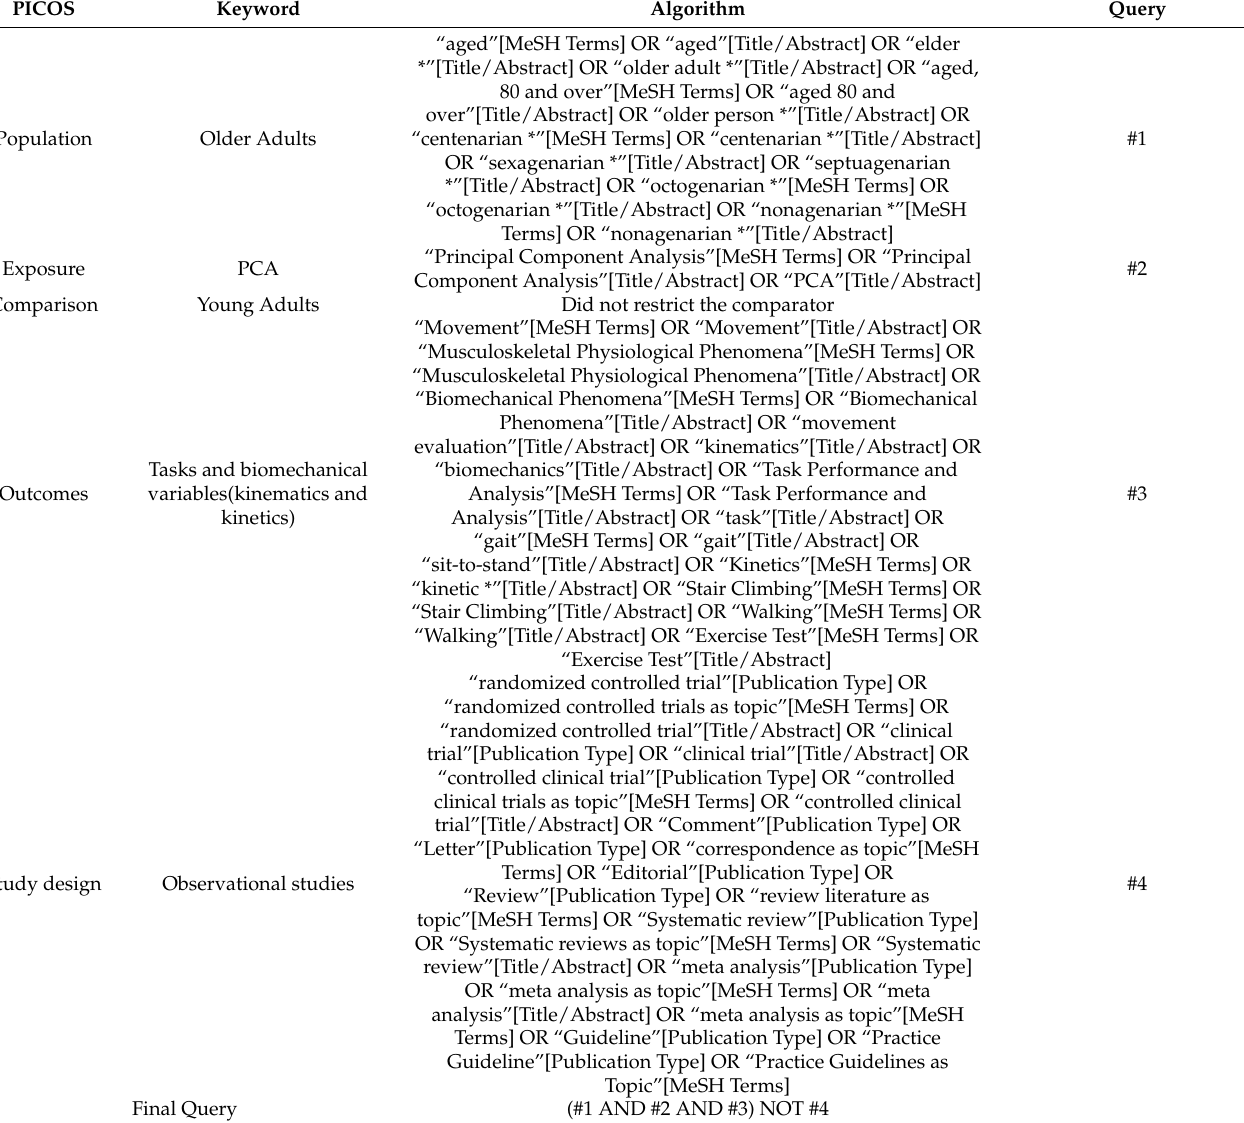
Table 1. PICO framework strategy and search algorithm used in Medline (Pubmed) database. (* After a word, a truncation symbol (wildcard) to retrieve plurals or varying endings, # Truncation symbol for one